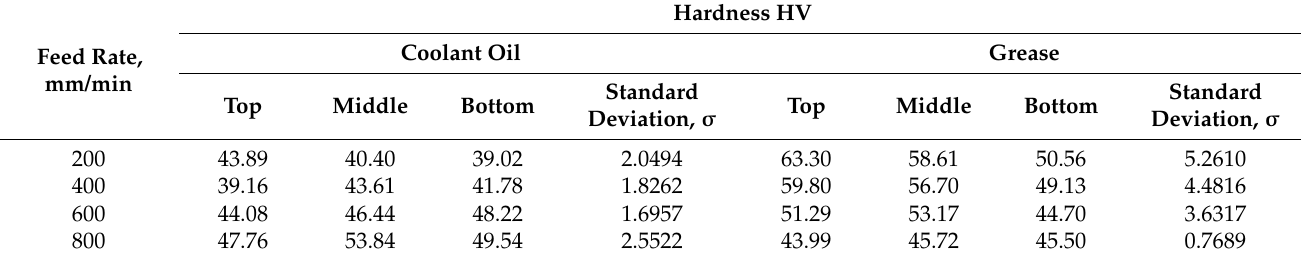
Table 5. Effects of different feed rates on